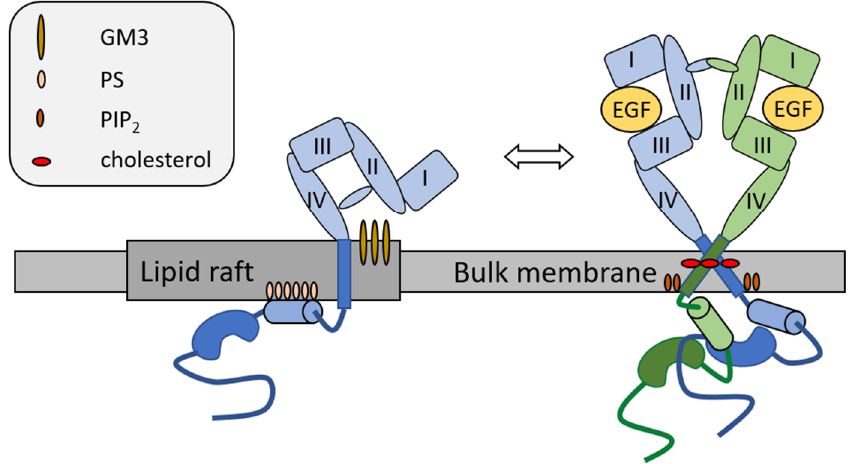
Figure 3. A brief overview of lipid-mediated effects on the EGF receptor. The inactive monomeric form of the receptor, displayed on the left, is stabilized by (i) direct interactions between multiple N-acetylglucosamine termini of the N-glycan moiety in the EGFR ECD and the oligosaccharides of GM3, and (ii) by electrostatic interactions between anionic PS species of the inner leaflet and three positively charged amino acid clusters of the JM-A segment resulting in membrane embedding of the JMD. Ligand binding induces conformational changes leading to the formation of the active dimer configuration, which involves cholesterol-mediated dimerization of the N-terminal GxxxG motifs of the TMDs. It is also facilitated by direct electrostatic interactions between PIP 2 lipids of the inner leaflet and proximal basic residues of the JM-A, helping the JMD being released from the membrane and formation of the antiparallel JMD dimer and the active, asymmetric kinase dimer. The process is accompanied by the exit of the EGFR from the lipid raft microdomains to the bulk membrane phase, releasing the receptors from inhibitory constraints.